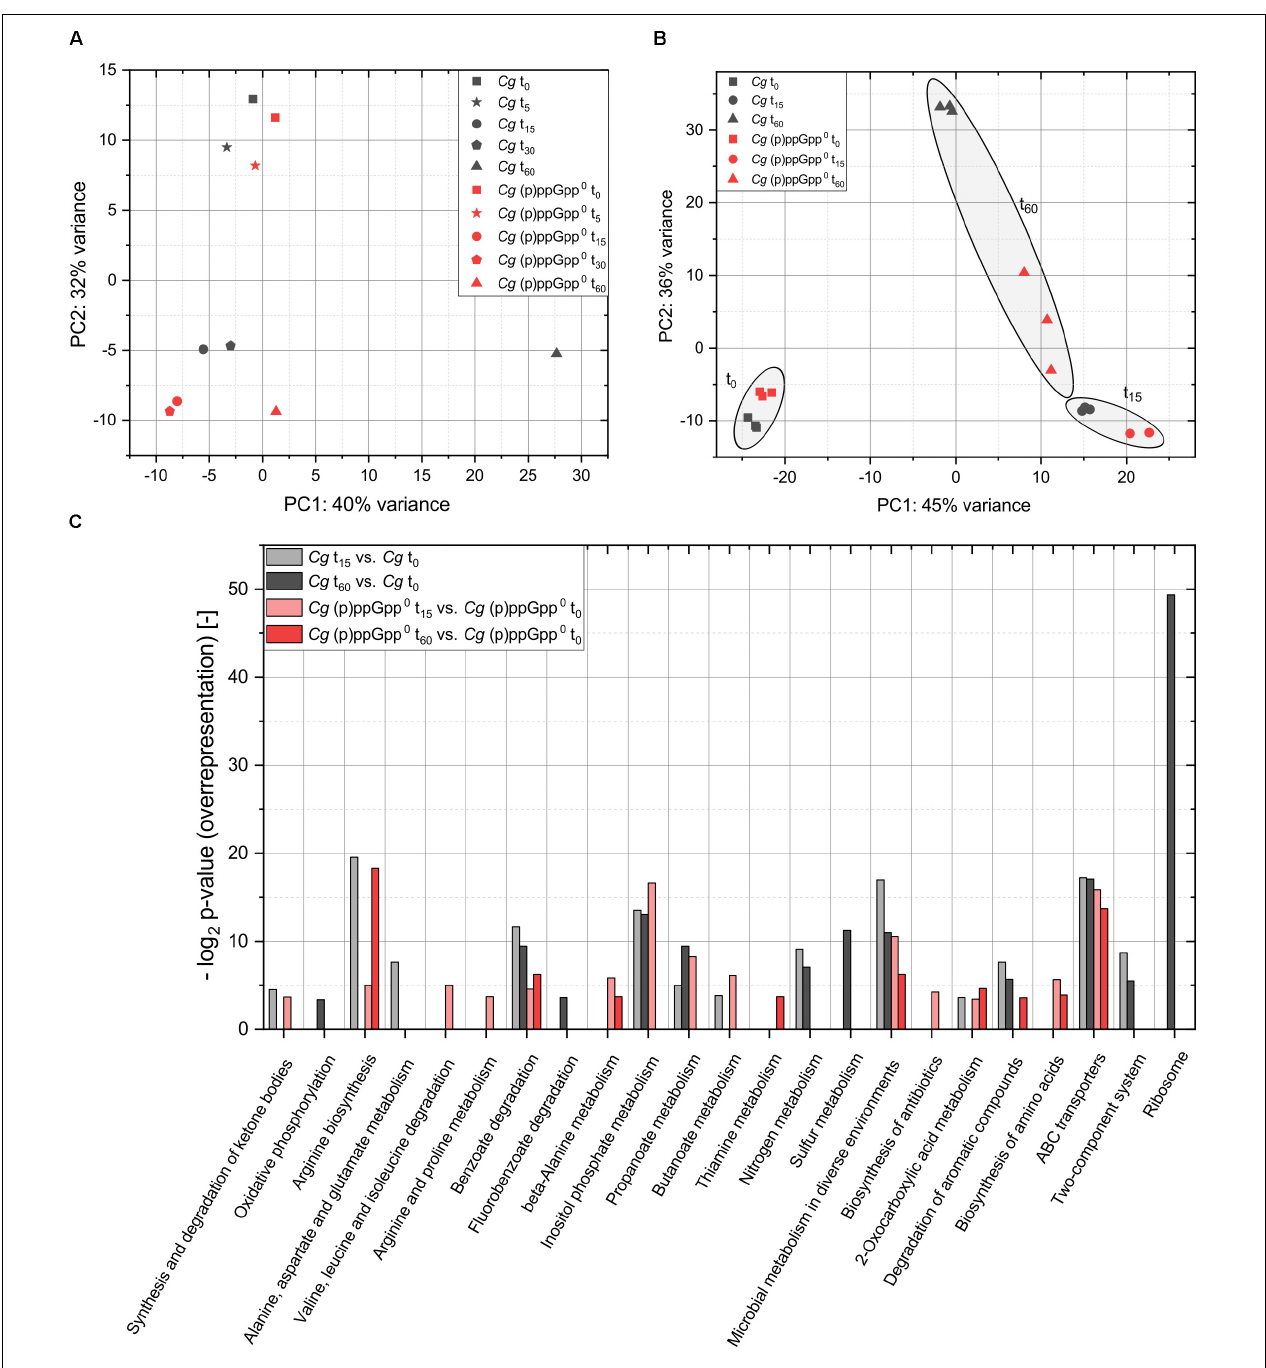
FIGURE 6 | Principal component analysis (PCA) and over-representation analysis (ORA) of the RNAseq data from total starvation analysis of CR099 and CR099 (cid:49) rel (cid:49) relS (cid:49) relH . (A) PCA of pooled biological triplicates for all time points sampled. (B) PCA of three biological replicates from three sampling points, prior to stress exposure and after 15 or 60 min of total starvation. Related data points of t 0 , t 15 , and t 60 are highlighted. Read counts were determined using ReadXplorer 2 (Hilker et al., 2016). After data normalization using DESeq2 , PCA analysis was performed with R (Love et al., 2014; R Core Team, 2018). (C) Over-representation analysis (ORA) of the differentially regulated genes with respect to their assignment to KEGG-pathways using DAVID 6.7 (Huang et al., 2009a,b).